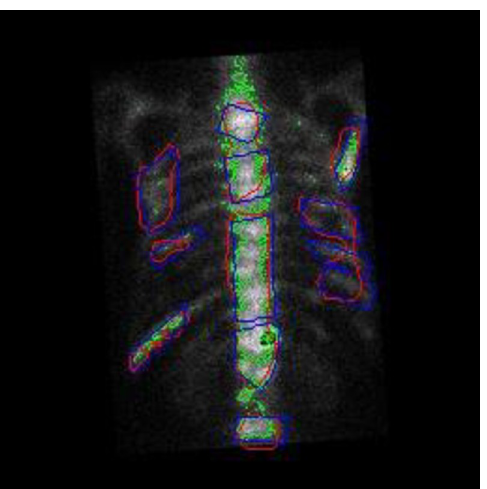
Fig 12. A comparison of K -means based (green), U-Net based (blue) and the manually labelled (purple) segmentation